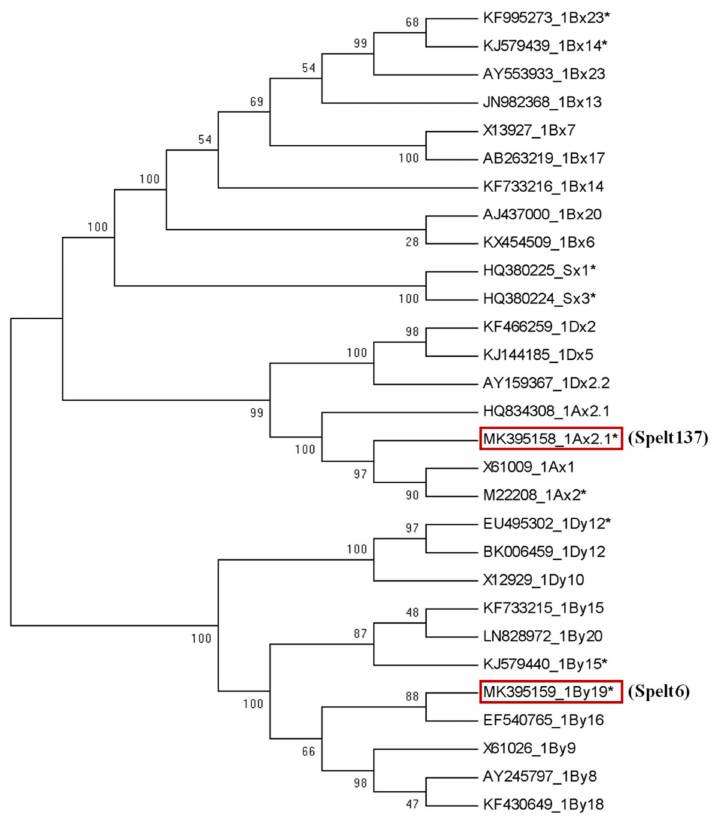
Figure 4. Phylogenetics of 1Ax2.1* and 1By19* genes and other 27 HMW-GS genes from A, B and D genomes of common wheat and related species. Bootstrap value ≥ 28% is indicated above or below the branches. The red frame indicates 1Ax2.1* and 1By19* genes, respectively. The 27 HMW-GS genes include X61009, M22208, KX454509, X13927, JN982368, KF733216, KJ579439, AB263219, AY553933, KF466259, AY159367, KJ144185, X61026, KF733215, KJ579440, EF540765, KF430649, X12929,